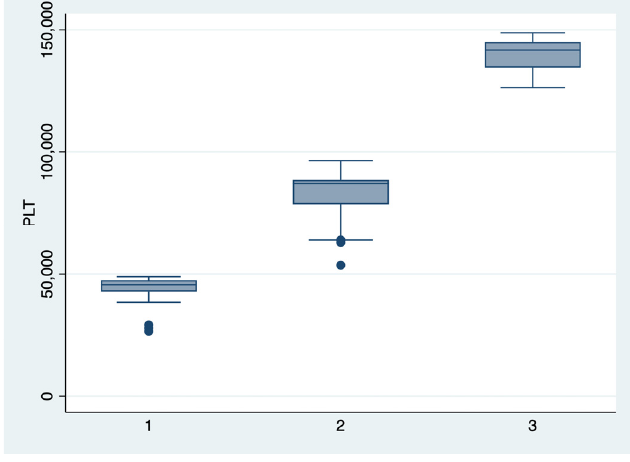
Figure 2. Boxplot representing the comparison of the platelets number in the subgroups 1, 2, and 3. Legend: PLT—platelets.